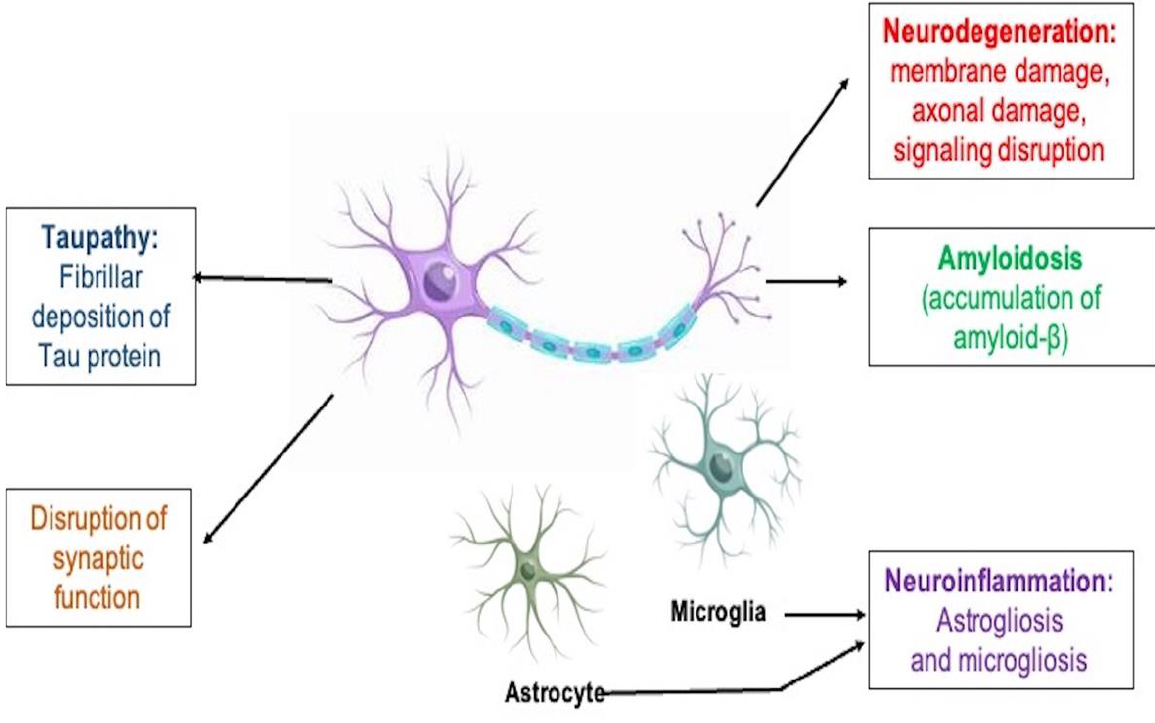
Figure 1. Biological indicators of AD ’ s histopathological changes.